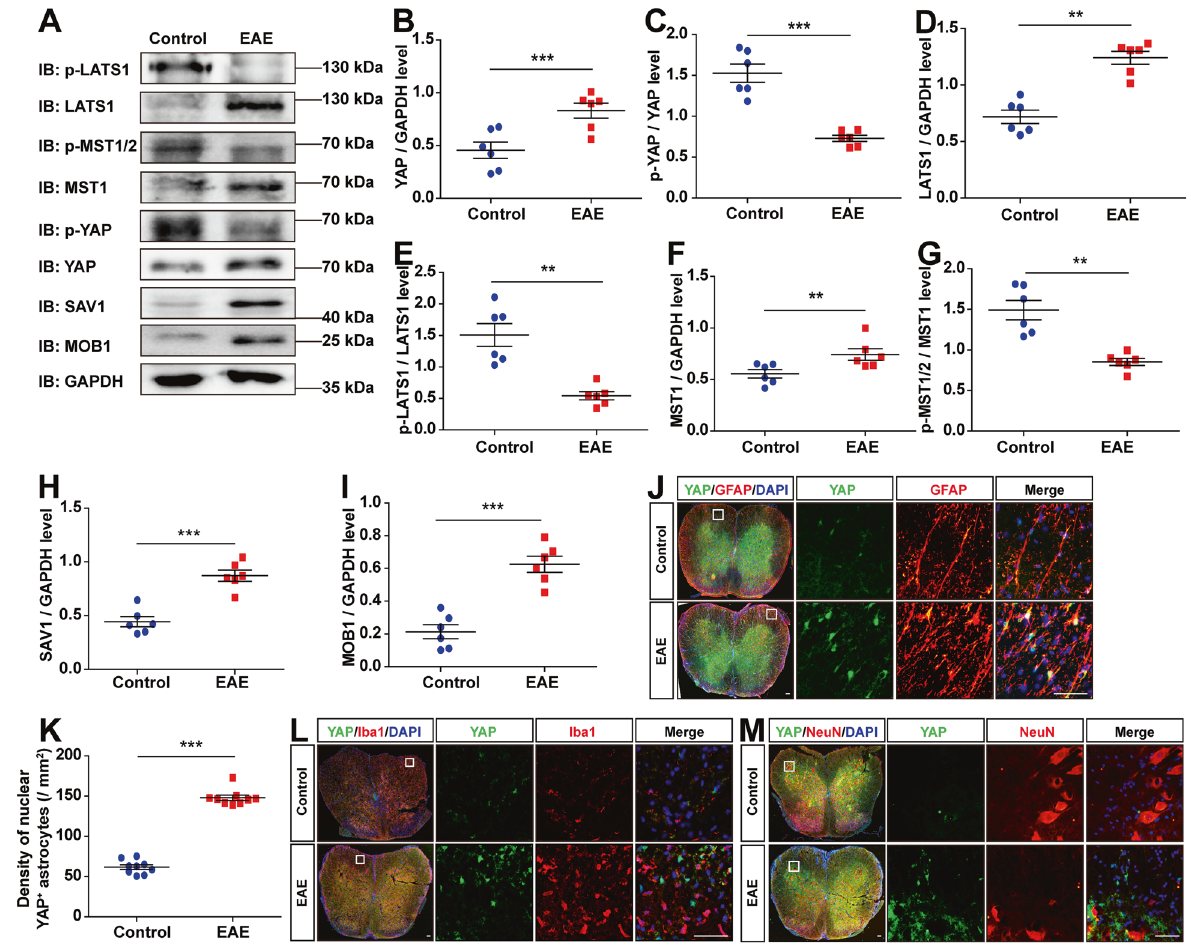
Fig. 1 YAP was upregulated and activated in astrocytes through suppression of the Hippo pathway in EAE mice. A Western blot showed the p-LATS1, LATS1, p-MST1/2, MST1, p-YAP, YAP, SAV1 and MOB1 expression in the lumbar spinal cords of control and EAE mice. B – I Quantitative analysis of the YAP ( B ), p-YAP/YAP ( C ), LATS1 ( D ), p-LATS1/LATS1 ( E ), MST1 ( F ), (p-MST1/2)/MST1 ( G ), SAV1 ( H ) and MOB1 ( I ) protein levels as shown in A ( n = 6, normalized to GAPDH). J Immunostaining of YAP (green) and GFAP (red) in the spinal cords of control and EAE mice. K Quanti fi cation of the density of nuclear YAP + astrocytes as shown in J ( n = 9). L , M Immunostaining of YAP (green) and Iba1 (red) ( L ) or YAP (green) and NeuN (red) ( M ) in the spinal cords of control and EAE mice. Scale bars, 50 μ m. Data were mean ± SEM. Student ’ s t -test, ** p < 0.01, *** p <